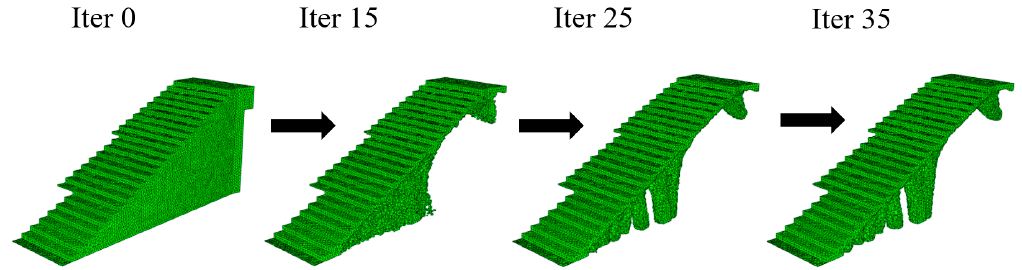
Figure 14. Load scenario and the boundary conditions associated with the bounding boxes B 1 ( left ) and B 2 ( right ).